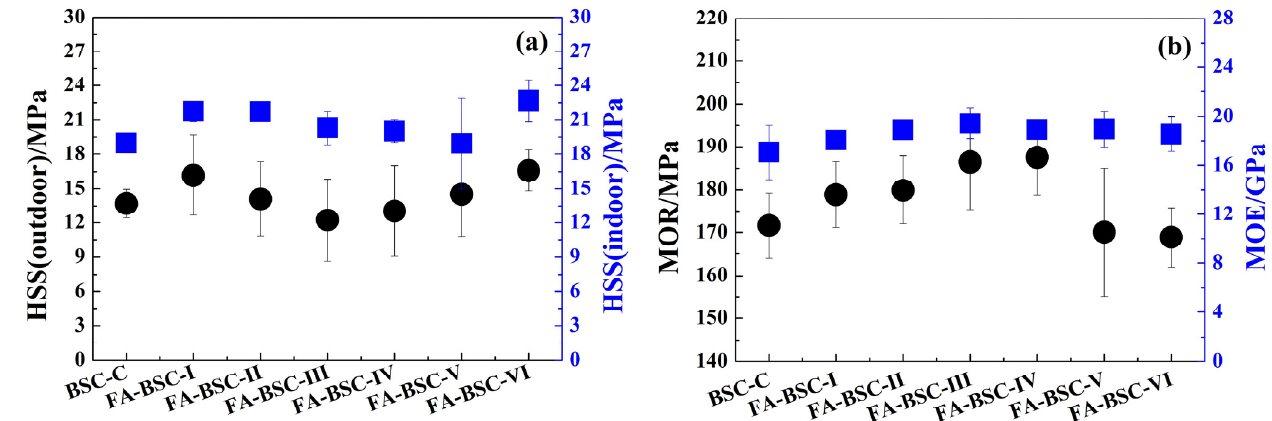
Figure 2. Mechanical properties of untreated BSC and furfurylated BSC. ( a ) HSS for outdoor and indoors; ( b ) MOR and MOE.